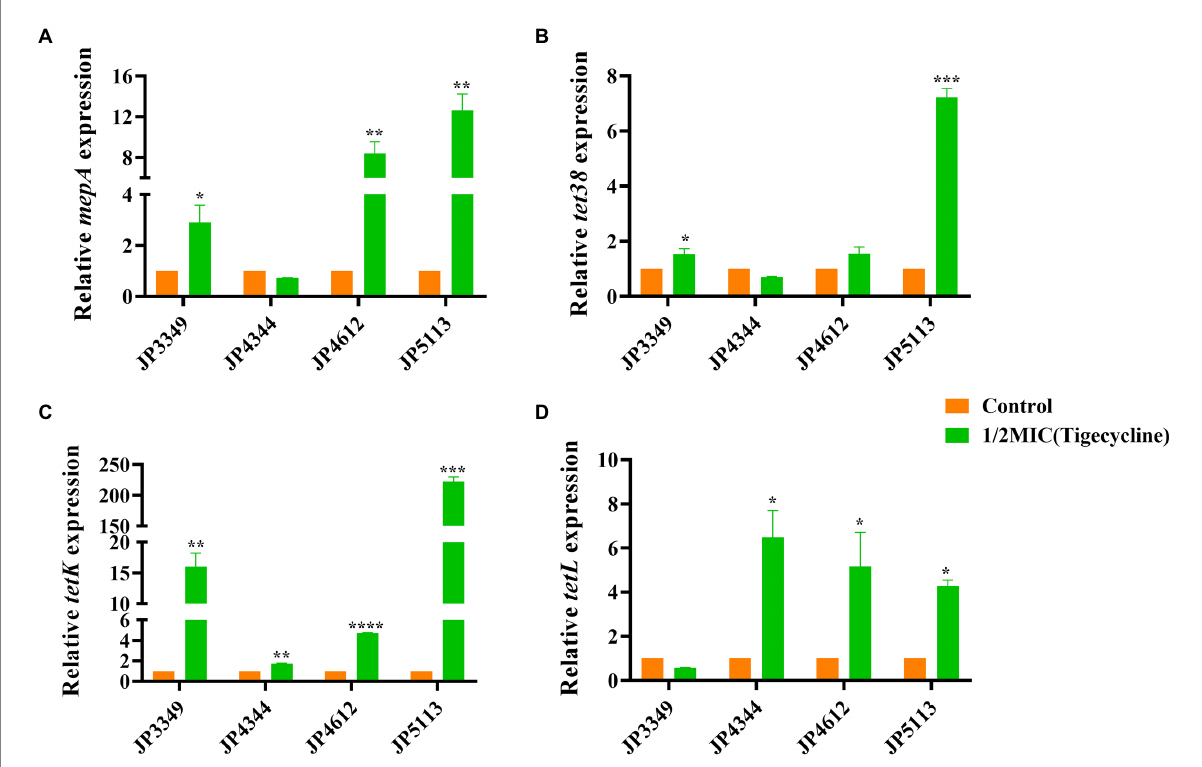
FIGURE 4 Fold changes in the expression of efflux pump-encoding genes in tigecycline-resistant Staphylococcus aureus exposed to 1/2 × MIC tigecycline concentrations. (A–D) The expression levels of mepA , tet38 , tet (K), and tet (L) genes. The values were normalized based on the internal control gene, gyrB . Data from the resistant strain with untreated 1/2 × MIC tigecycline were normalized to 1 to allow the comparison of data across different samples. Data represented the mean values from 3 independent experiments with error bars indicating standard deviations, and asterisks denoted the significance of differences in the expression by the paired Student’s t -test (* p < 0.05; ** p < 0.01; *** p < 0.001; **** p <